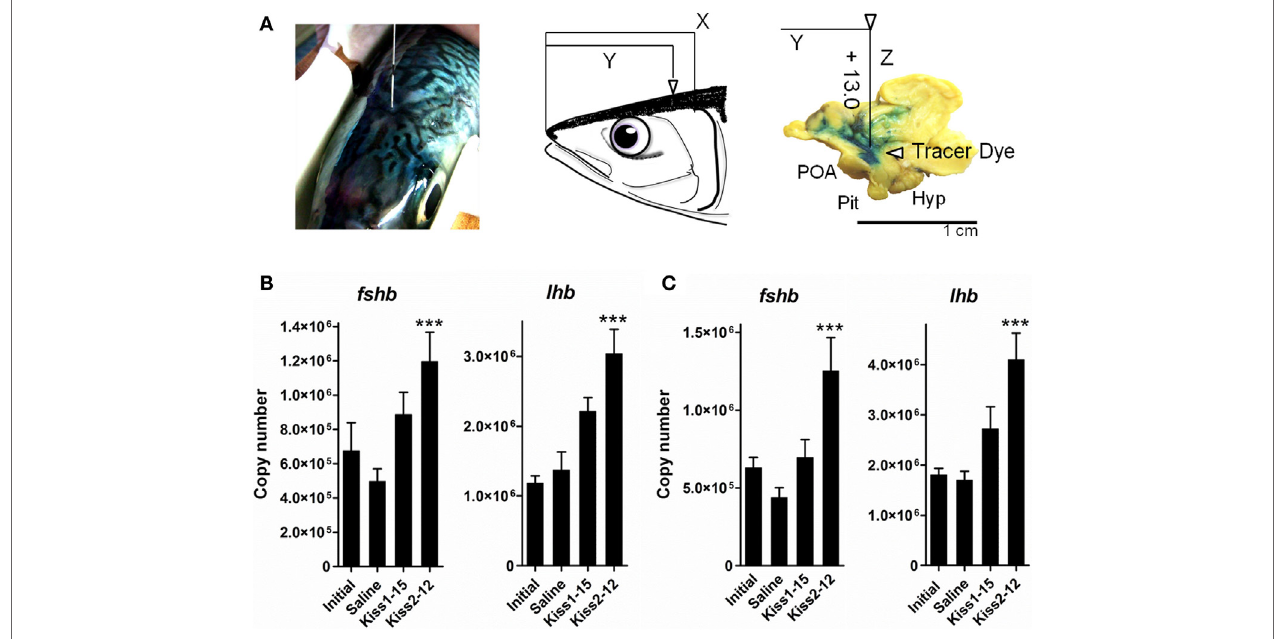
FigURe 2 | Schematic illustration of coordinates for injection into the intracerebroventricular (i.c.v.) region of chub mackerel (A) . We determined that if head length (rostral end to upper end of gill) was assumed to be X and length of the rostral end to immediately above the third ventricle was assumed to be Y , the ratio of X to Y converged from 1.4 to 1.0. Tested peptide or PBS with blue dye was administered into the third ventricle to a depth of 13 mm below the tissue surface. Abbreviations: Hyp, hypothalamus; Pit, pituitary; POA, pre-optic area. (B,C) Analysis of the effect of i.c.v. administration of Kiss1-15 and Kiss2-12 peptides on fshb and lhb mRNA levels in the pituitary at 12 h post-administration, each together in adult male (B) or female (C) immature subjects. Transcription levels are the mean ± SEM of 9–16 independent determinations. *** P < 0.001, one-way ANOVA followed by a Tukey’s multiple comparison test. Modified from Ref. (45), by permission of